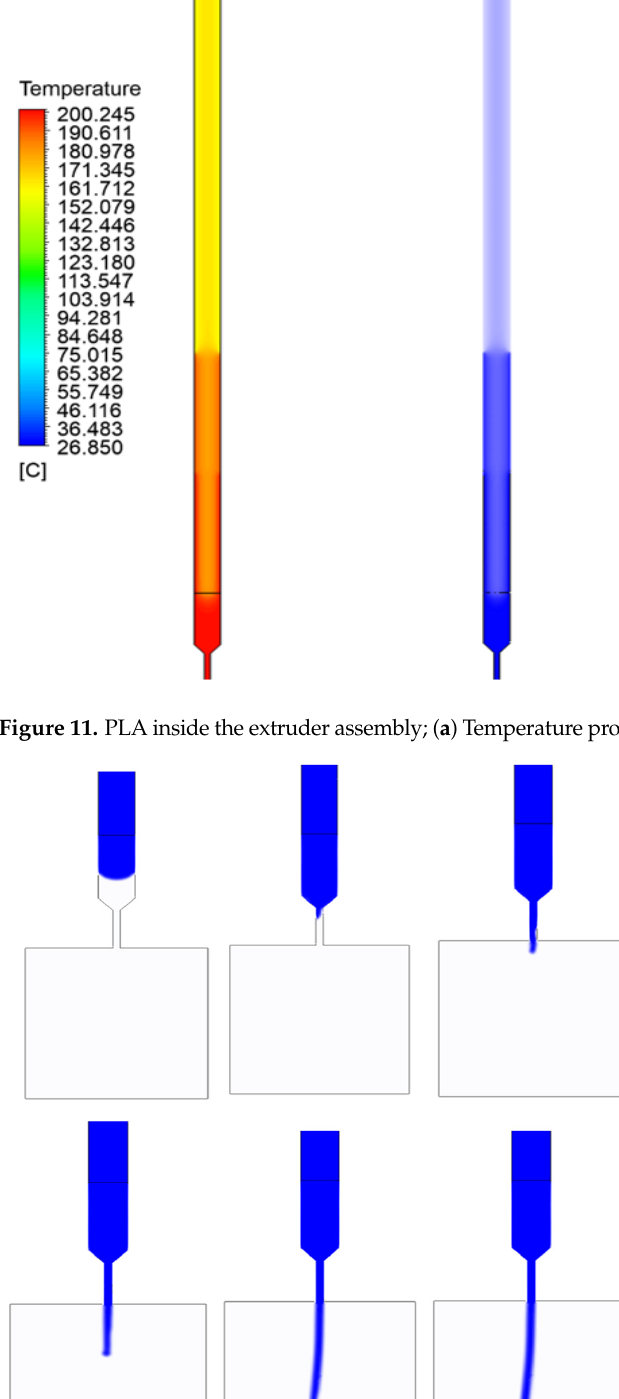
Figure 11. PLA inside the extruder assembly; (a) Temperature profile of PLA; (b) Liquid fraction of PLA.